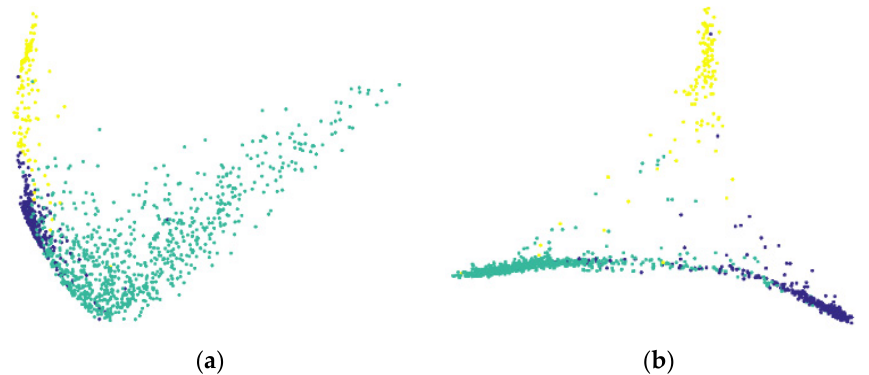
Figure 6. The visualization of the embedding vectors obtained by MobileNet-V3-Small trained with different kinds of loss functions. ( a ) Cross entropy; ( b ) cross entropy combined with BSTriplet.